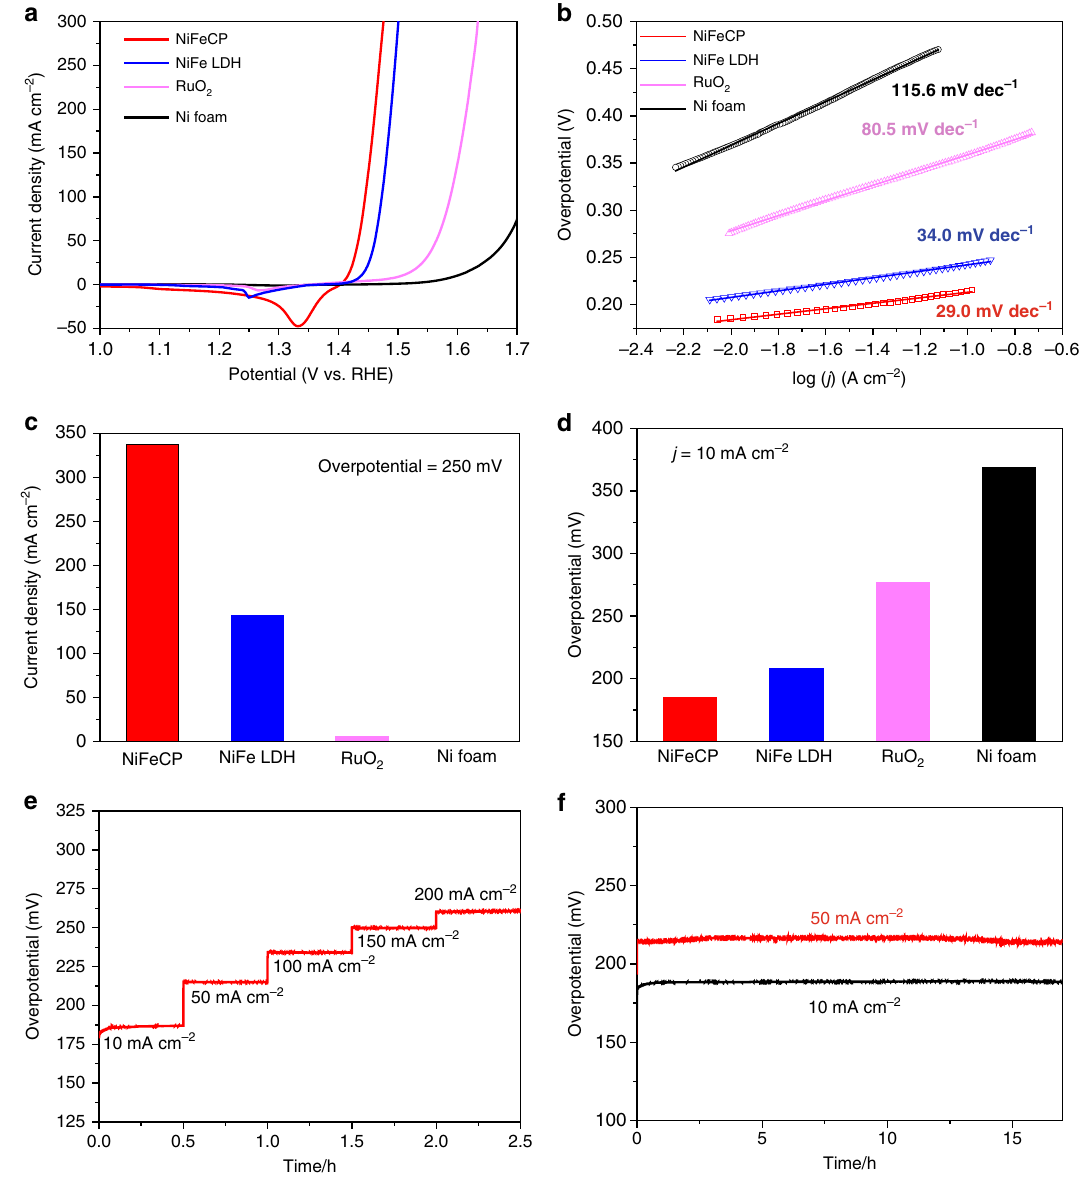
Fig. 2 Electrochemical characterizations for OER. a Linear sweep voltammetry (LSV) curves of NiFeCP/NF , NiFe LDH/NF , RuO 2 /NF, and Ni foam. b NiFeCP/NF , NiFe LDH/NF , RuO 2 /NF, and Ni foam. c Current densities at an overpotential, η = 250 mV, as a function of electrode type. d The η required for j = 10 mA cm − 2 as a function of electrode type. e Chronopotentiometric measurements of OER in 1.0 M KOH as a function of current density. f Extended chronopotentiometric measurements at j = 10 mA cm − 2 and j = 50 mA cm − 2 for 17 (Supplementary Fig. 2b) for OER when the Ni:Fe ratio was 7:3 in the electrodeposition solution, thus, this electrode was system- atically studied in this work, and abbreviated as NiFeCP/NF in this paper.